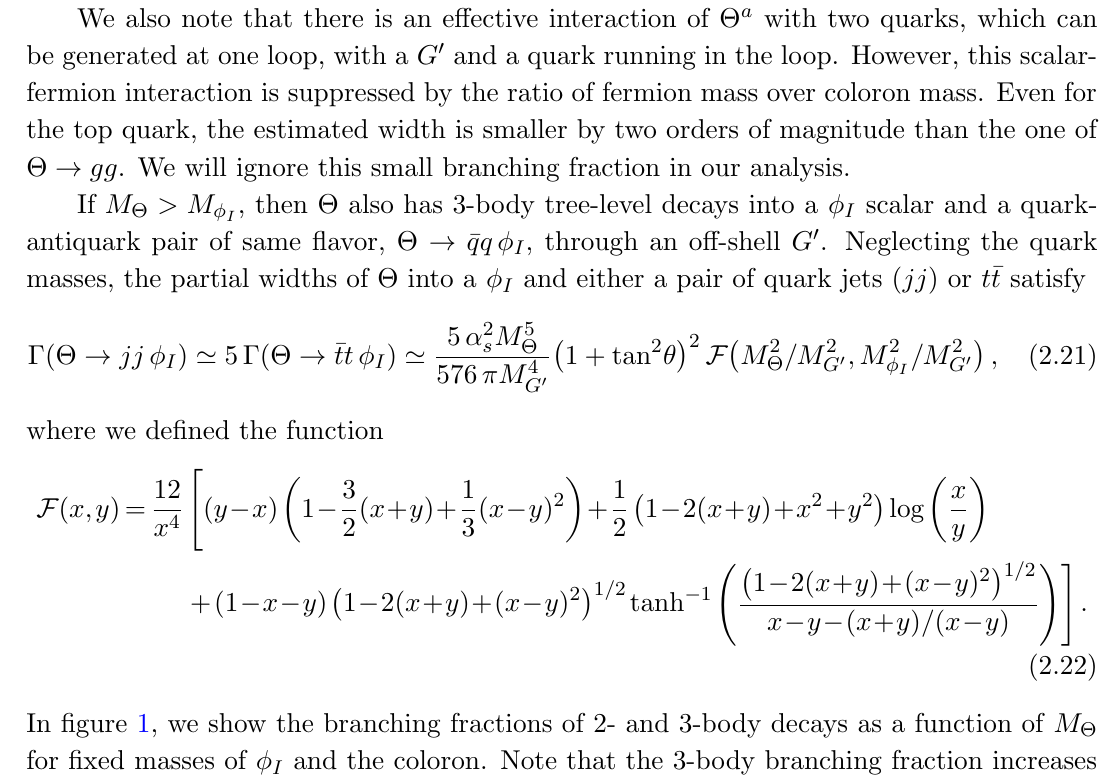
Figure 1 . Branching fractions of the color-octet scalar (cid:2) as a function of its mass. For (cid:2) the width is summed over the (cid:12)ve light quark (cid:13)avors in the (cid:12)nal state. The branching fraction for (cid:2) t (cid:22) t(cid:30) I (not shown) is slightly less than 1/5 of that for (cid:2) ! here is M G = 3 TeV (left panel) or 5 TeV (right panel), and the neutral scalar mass is (cid:12)xed at 0 M (cid:30) = 300 GeV. The parameter tan (cid:18) , which determines the strength of the coloron couplings, is I taken to be 0.2 (solid lines) or 0.5 (dashed